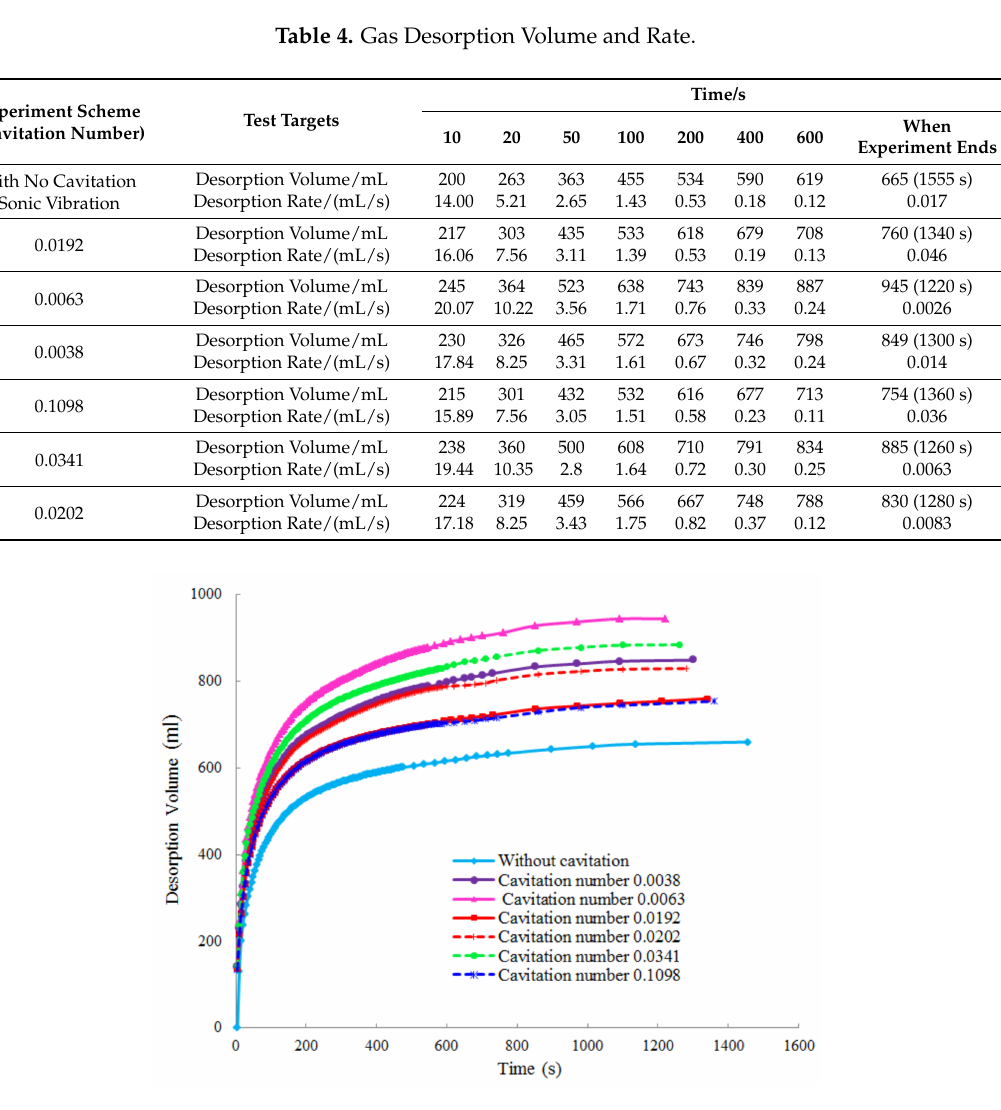
Figure 14. Gas desorption volume curve with time for various cavitation